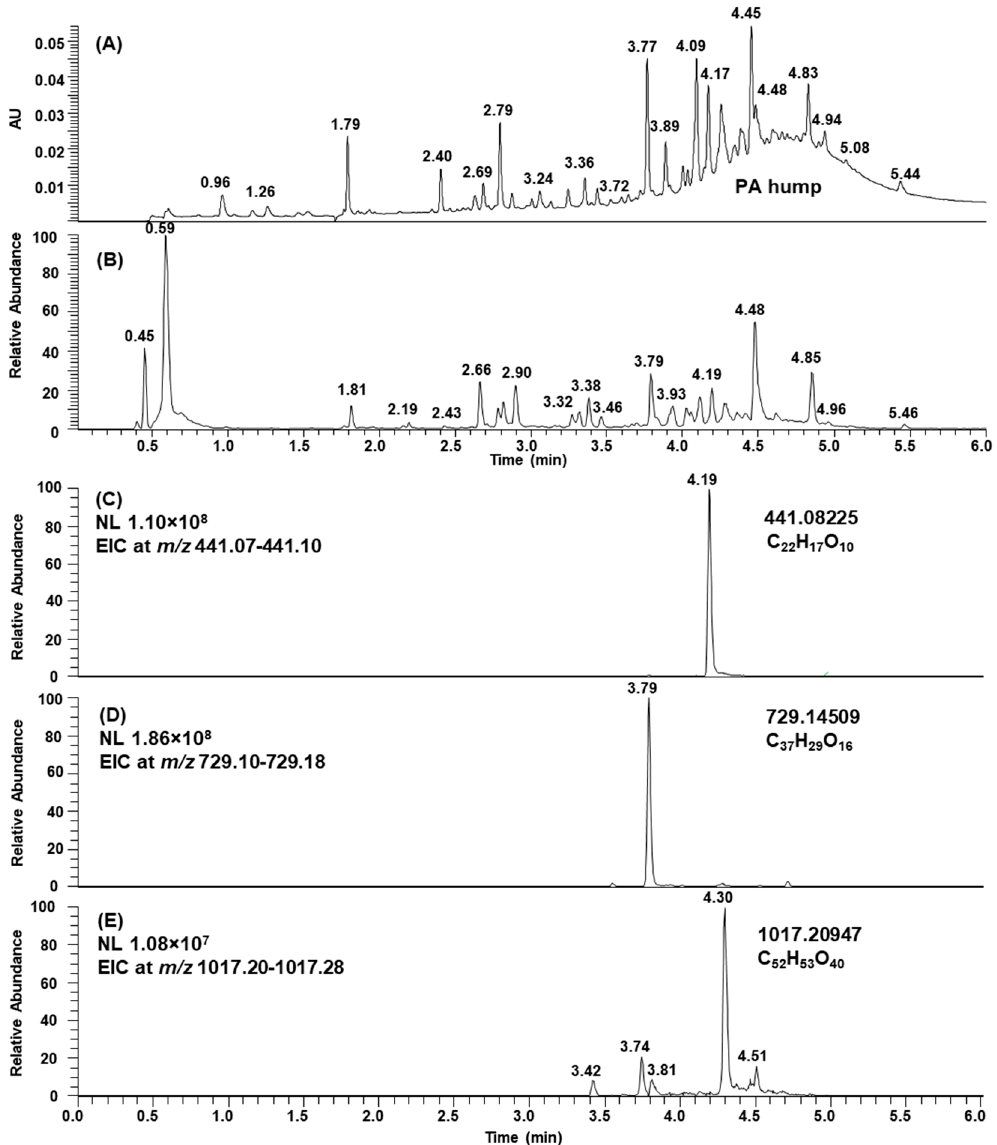
Figure 2. ( A ) UV chromatogram at 280 nm, ( B ) total ion chromatogram, ( C ) extracted ion chromatogram (EIC) at m / z 441, ( D ) EIC at m / z 729, and ( E ) EIC at m / z 1017 of the leaf extract of Ruprechtia salicifolia . PA = proanthocyanidin, NL = normalized intensity.